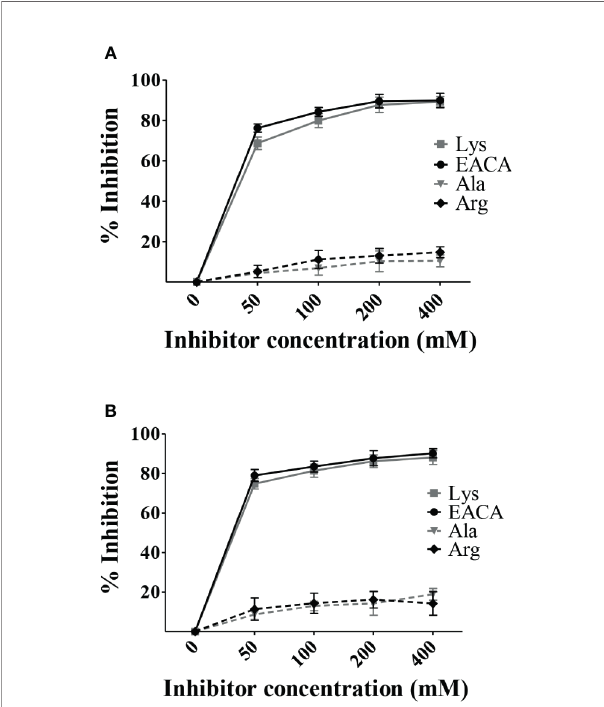
FIGURE 2 | Free L-lysine inhibits interactions between Plg and the MK-rich domain. (A, B) , Selective inhibition of rMK-rich/rPbsP-Plg interactions. Competitive ELISA assays were done with immobilized rMK-rich or rPbsP (250 nM) to which Plg (100 nM) was added in the presence of increasing concentrations of e -aminocaproic acid (EACA) or L-lysine (Lys). L-alanine (Ala) and L-arginine (Arg) were used as negative controls. Inhibition ability is shown as percentage. Data are means ± SD from three independent experiments conducted in